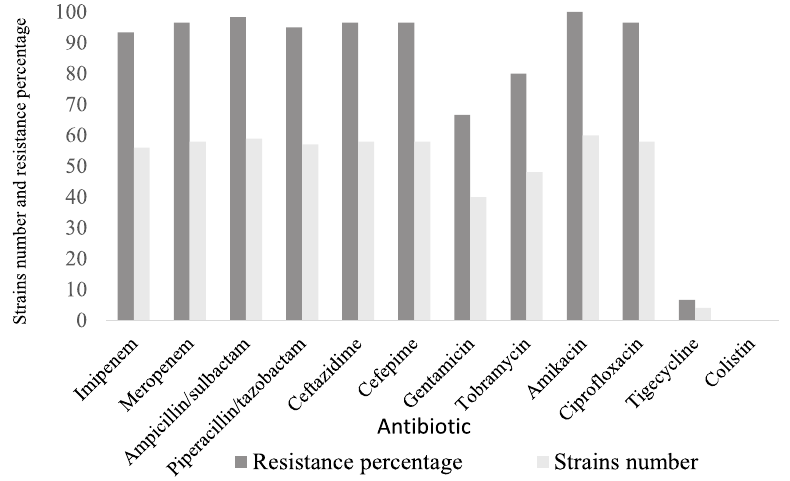
Fig. 1. Percentage of antibiotic resistance in A. baumannii strains. Table 3. Minimum inhibitory concentrations breakpoint for an extensively drug-resistant strain of A. baumannii